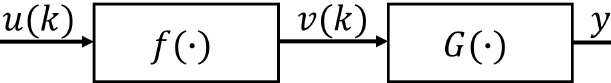
Figure 3. Hammerstein